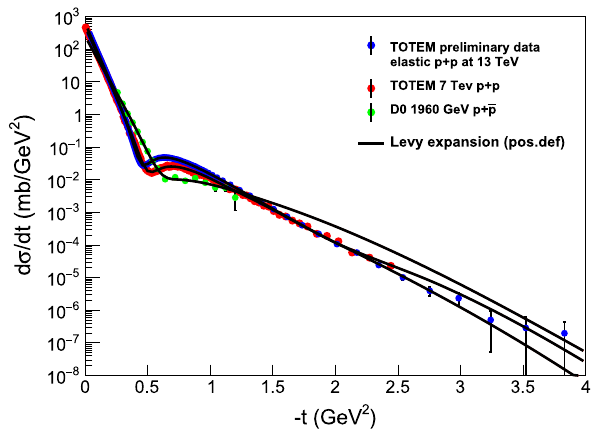
Fig. 19 Adirectcomparisonofthedifferentialcross-sectionsofelastic pp scattering at the LHC energies of 7 and 13 TeV, with p ¯ p elastic scattering at the Tevatron energy of 1.96